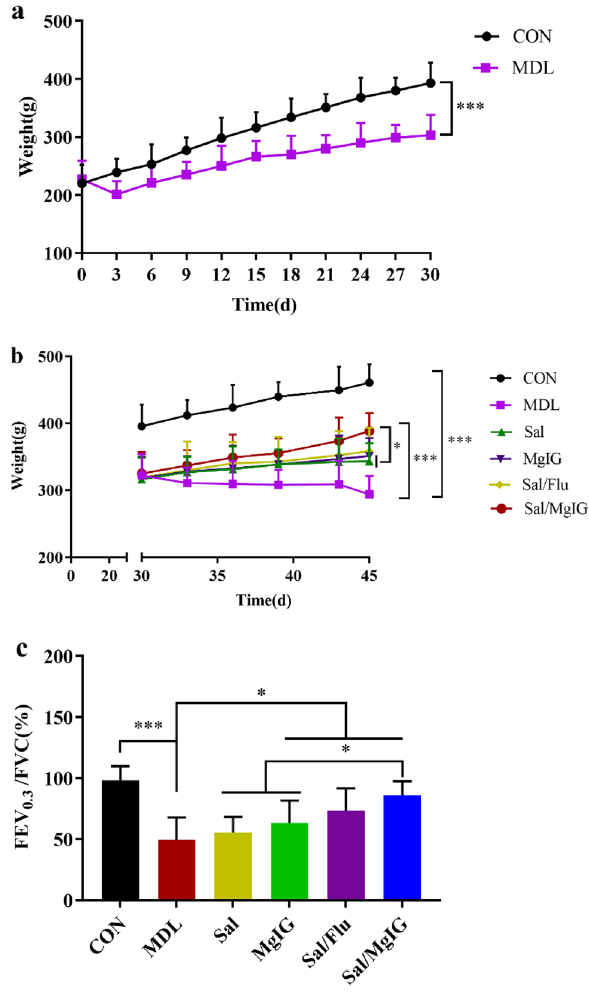
Figure 1. Effects of Sal or/and MgIG on body weight and pulmonary function in COPD rats. ( a ) Changes of body weight of the rats during 30-day COPD model construction. ( b ) Changes of body weight of the rats in different groups during treatment. ( c ) Comparison of FEV 0.3 /FVC of rats in different groups after treatment for pulmonary function evaluation. All data were presented as mean ± standard deviation (n = 10 in each group). Statistical significance of differences was determined by one-way ANOVA. ***p < 0.001, **p < 0.01 and *p < 0.05 was considered to indicate a statistically significant difference. FEV 0.3 forced expiratory volume in 0.3 s, FVC forced vital